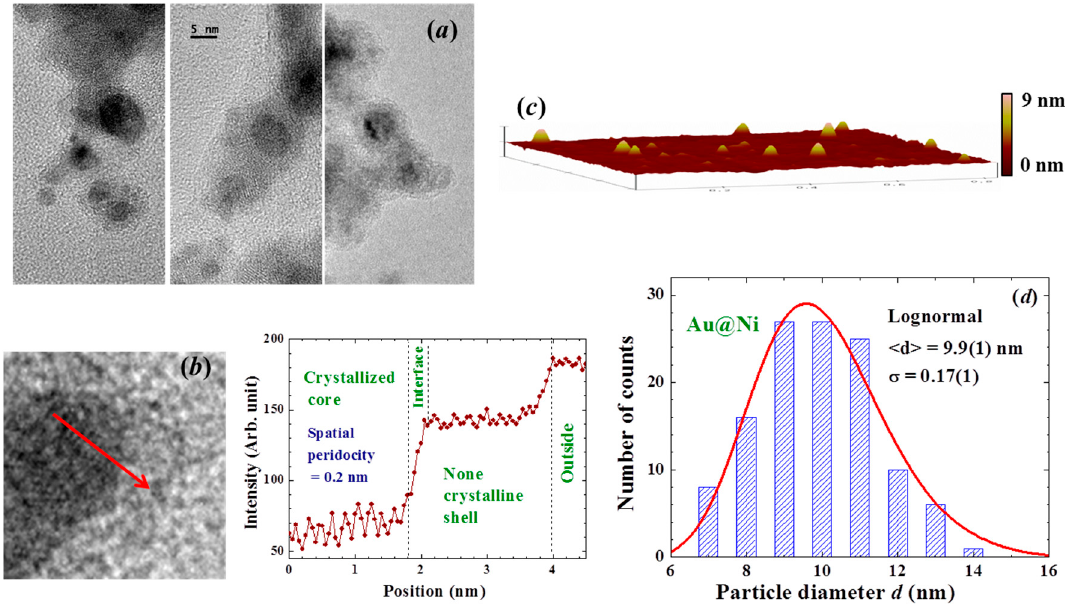
Figure 12. ( a ) representative HRTEM images of the Au/Ni NP, revealing the spherical core/shell structure of the NP; ( b ) enlarged HRTEM images focused in the interface regime, revealing a lattice periodicity fringe for the atoms in the core, but no spatial periodicity may be identified for the atoms on the shell; mean TEM intensity of the Au/Ni NP in the interface regime; ( c ) representative AFM images of the Au/Ni NP; and ( d ) size distribution obtained from the AFM and HRTEM images. The solid line indicates the results of the fit to a lognormal function, giving a mean particle diameter of 9.9 nm.